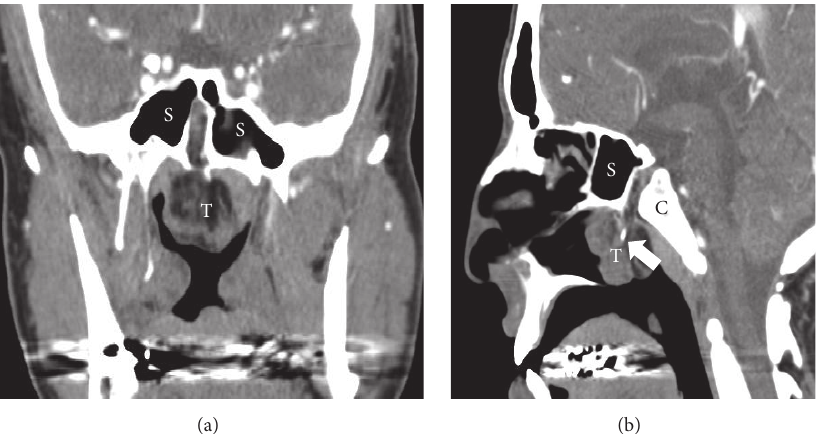
Figure 2: CT angiogram (CTA) imaging of pedunculated skull base lesion. (a) Coronal CT slice at level of the bilateral sphenoid sinuses (S), with tumor pedicle arising between sinus cavities, at typical site of intersinus septum. The 4×4 cm tumor (T) is composed of heterogeneously dense material, with suspected low-density (dark) fat seen. (b) CTA in sagittal view, showing relationship of tumor pedicle extending between anterior sphenoid sinus (S) and posterior clivus (C). Arrow shows the diminutive artery coursing through the pedicle, without direct communication with the ICA and vertebrobasilar system (not